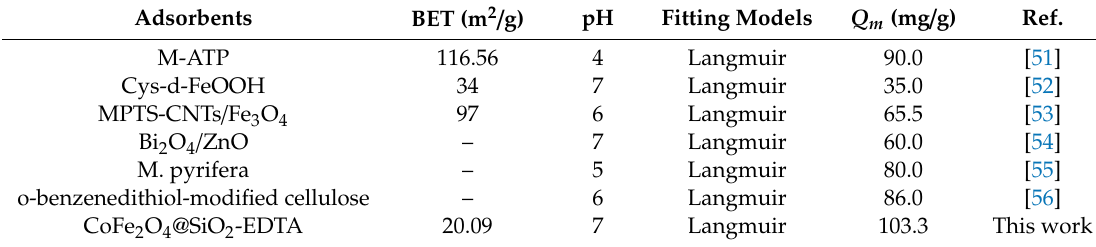
Table 4. Comparison of adsorption capacities for Hg(II) onto di ff erent absorbents.